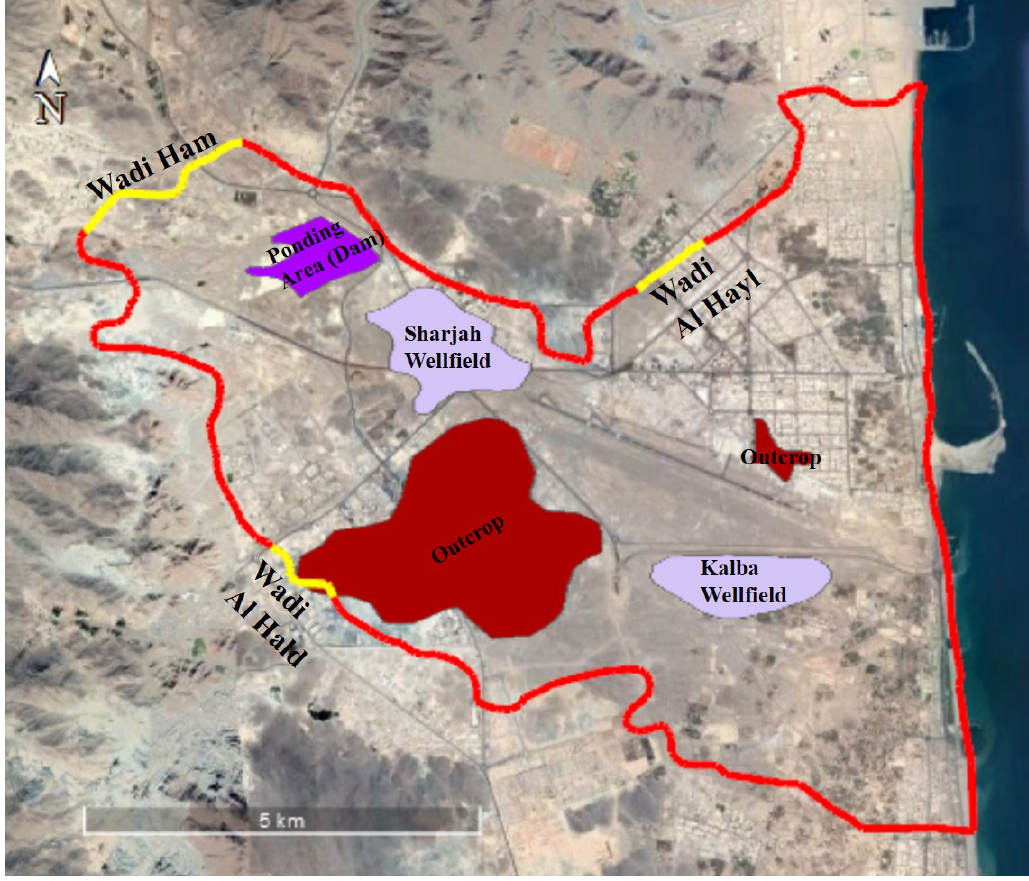
Figure 2. Land satellite image of Wadi Ham area including main features (Revised from Sherif et al., 2014].